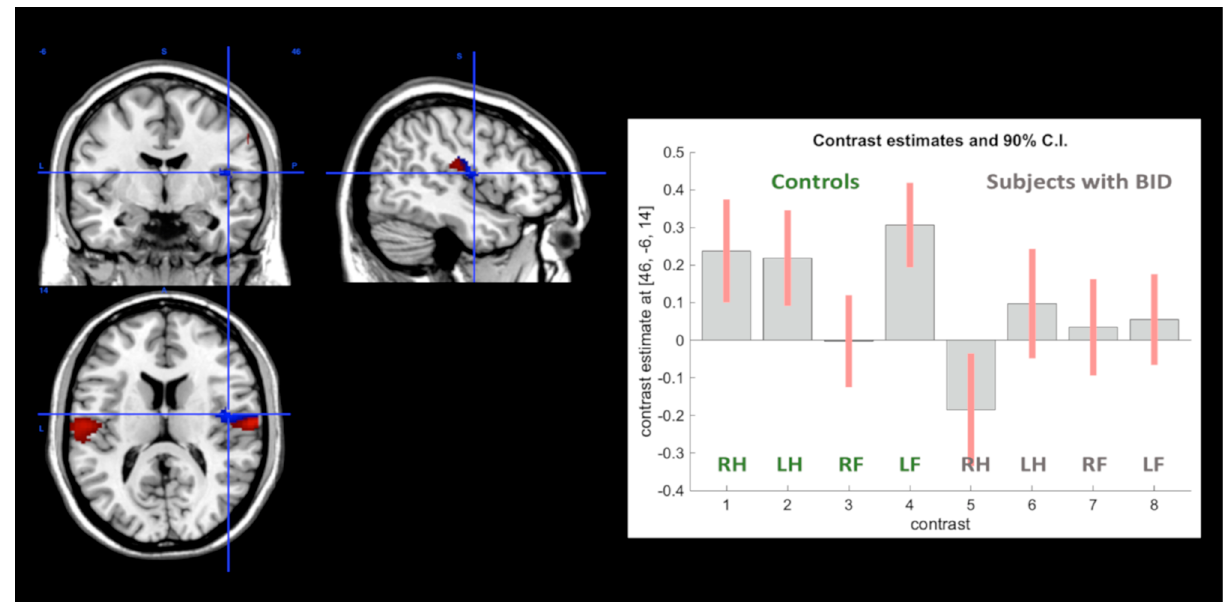
Figure 2. The Group-by-Body Part-by-Side interaction in right area SII for the somatosensory stimulations (voxels in blue) . The bar graphs illustrate the contrast estimates—betas—and their 90% confidence intervals of the fMRI response in the right SII (MNI coordinate: x = 46; y = − 6; z = 14; p = 0.001) in controls and participants with BID during the tactile stimulation of the different body parts. The surrounding areas in red are voxels where the main effect of reduced activation for tactile stimuli in subjects with BID within area SII was observed.